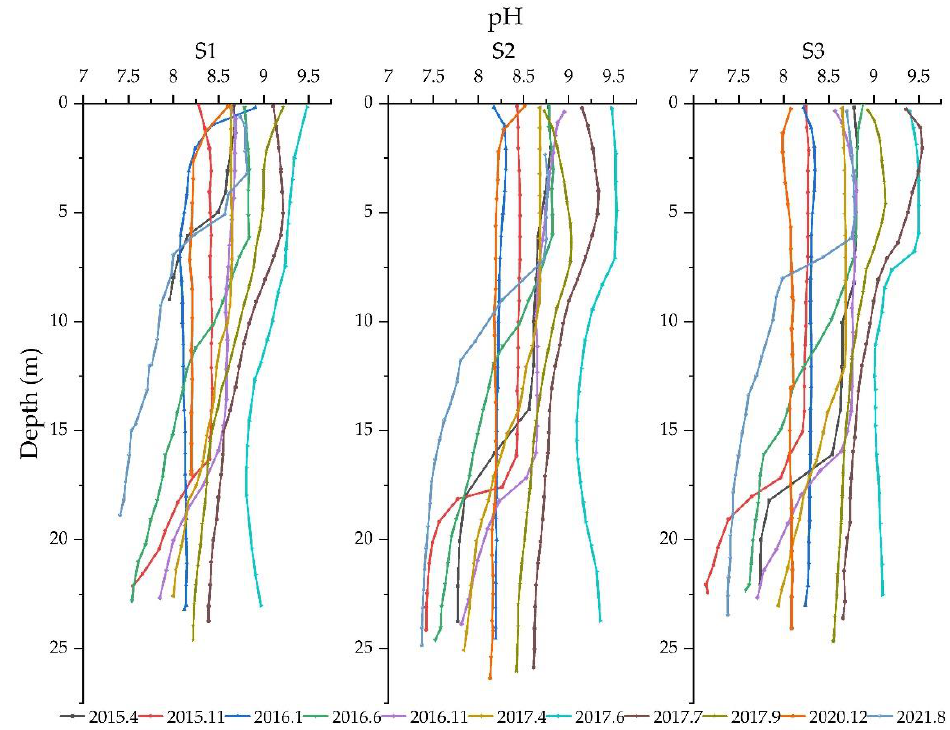
Figure 4. Vertical pH profile in Lake Yangzong.